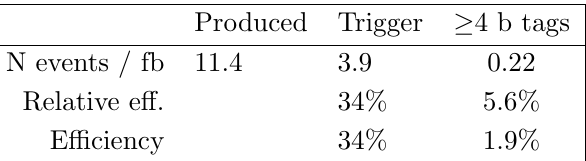
Table 2 . Cut-(cid:13)ow e(cid:14)ciency for the SM signal pp ! HH ! bbbb; the e(cid:14)ciency and the relative reduction of each successive selection step is shown. The number of expected SM signal events for an integrated luminosity of 1 fb (cid:0) 1 is also